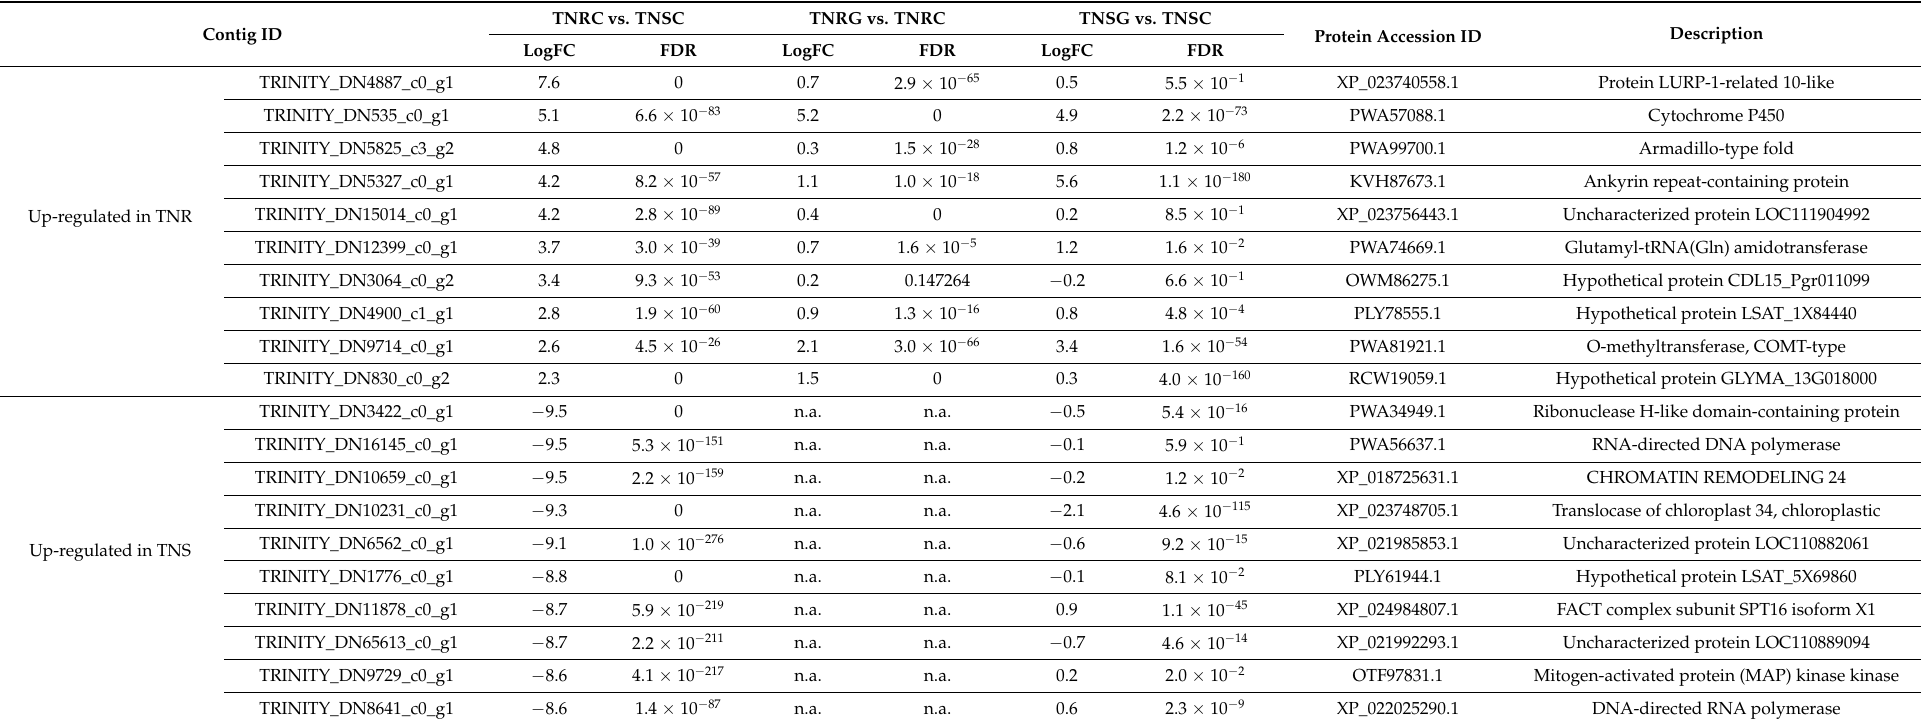
Table 8. Top 10 gene list of significantly up- or downregulated genes in TNRC vs. TNSC. The genes whose expressions were up- or downregulated in TNR compared to TNS without glyphosate treatment are listed in this table (FC > 4 or FC < − 4; FDR < 0.05). When we filtered out low read counts (<20 read average), 127 and 181 genes remained in the up- and downregulated groups, respectively (Tables S5 and S6). Among these, we were able to predict the protein function of 202 genes. The top 10 genes having a higher or lower FC with protein accession numbers are listed in this